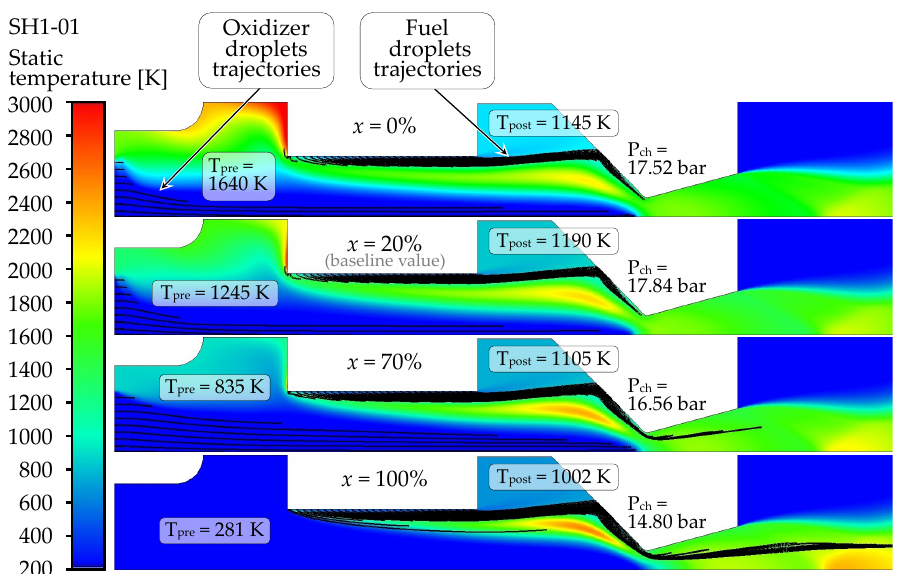
Figure 17. Influence of the oxidizer vapor quality x on the flowfield for case SH1-01.